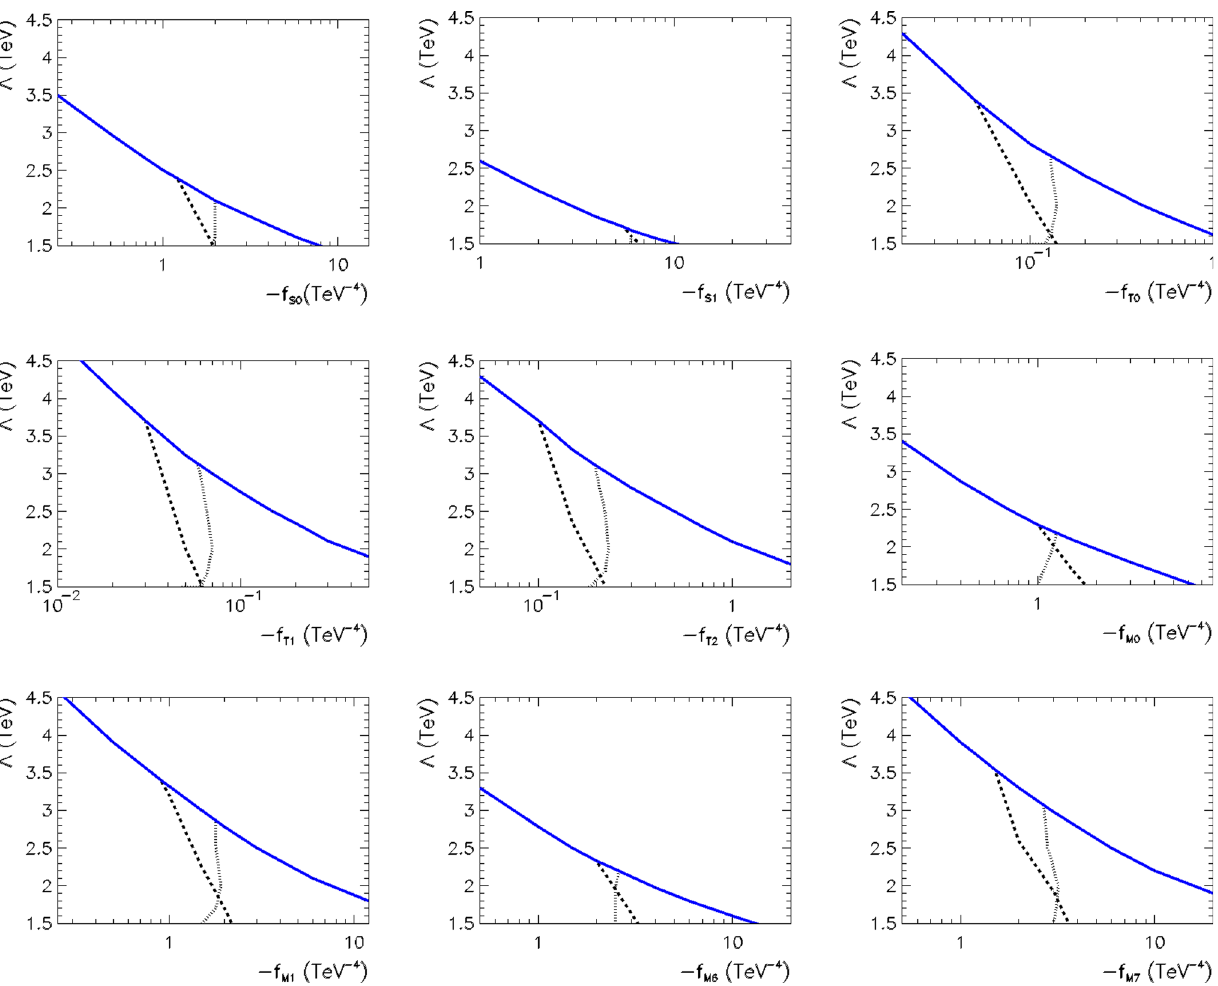
Fig. 5 Regions in the (cid:3) vs f (negative f values) space for dimension-8 operators in which a 5 σ BSM signal can be observed and the EFT is applicable. For the meaning of curves see caption of Fig. 4. Assumed is